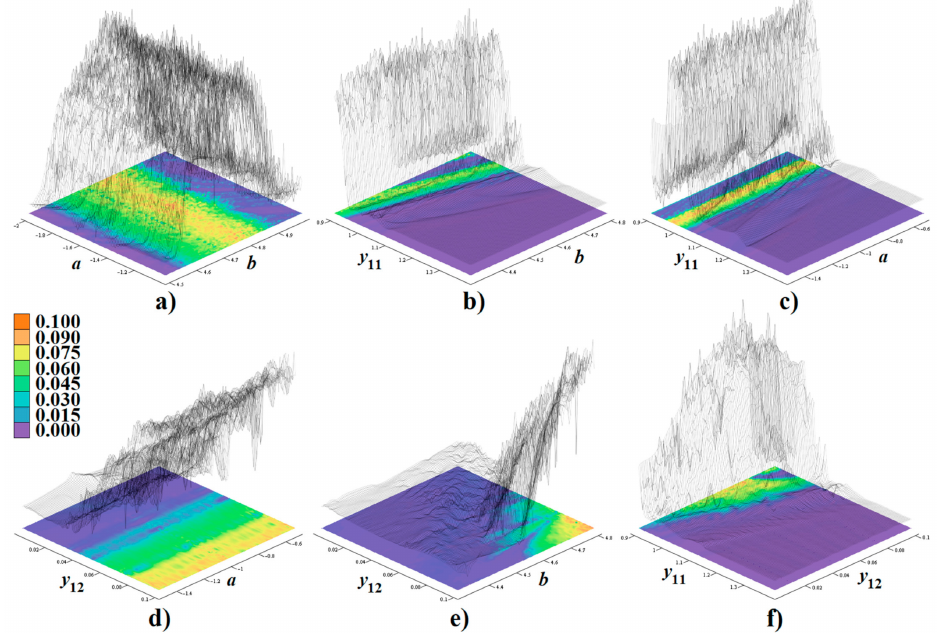
Figure 3. Rainbow-scaled surface-contour plot of the largest LE zoomed on the area around a set of parameters (12): ( a ) a vs. b , ( b ) y 11 vs. b , ( c ) y 11 vs. a , ( d ) y 12 vs, a , ( e ) y 12 vs. b , and ( f ) y 11 vs. y 12 . Color scale provided on the left side corresponds to the largest